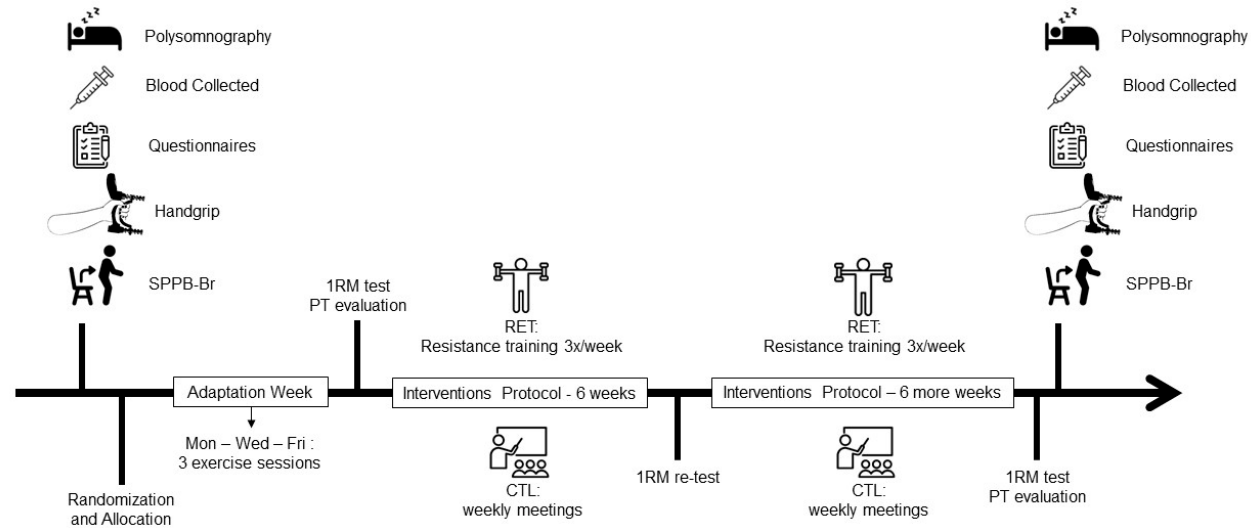
Figure 2. Step study diagram. After recruiting the volunteers, full-night sleep polysomnography was performed. Immediately after waking, blood collection was performed, followed by the application of the questionnaire, the handgrip test, and the physical performance test battery. After randomization, allocation, and adaptation to the tests, 1RM (repetition maximum) and PT (peak torque) were performed. After 6 weeks, a new 1RM test was conducted in the RET group to adjust the training load, and 24 h after the end of the 12 weeks of interventions, 1RM and PT were re-evaluated. Sleep, biochemistry, questionnaire, and physical parameters were tested after 48 h post-training. SPPB-Br: Brazilian version of Short Physical Performance Battery; CTL: control group; RET: exercise training.